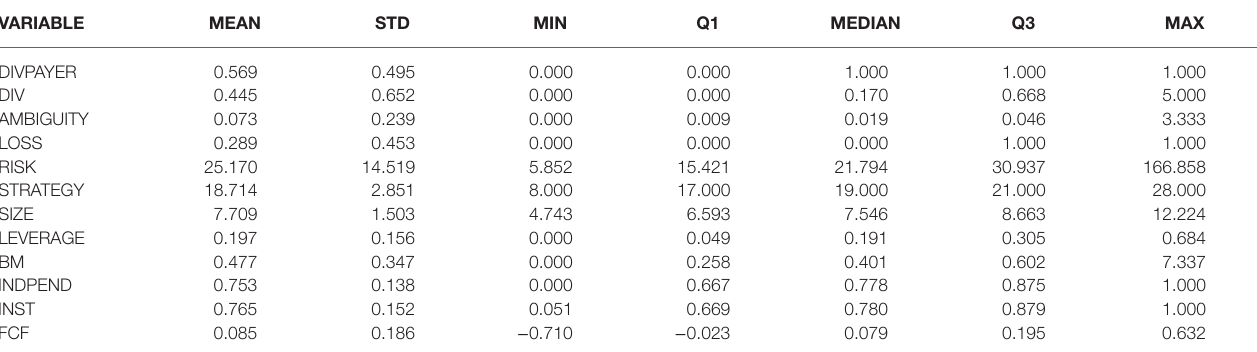
TABLE 2 | Descriptive statistics.